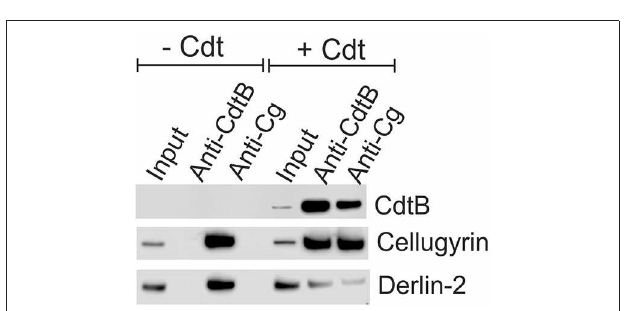
FIGURE 4 | Immunoprecipitation of cellugyrin, Derlin-2, and CdtB. THP-1 WT cells were treated with medium or Cdt (2 µ g/ml) for 2h and then washed and homogenized as described in Materials and Methods. Supernatants were immunoprecipitated with either immobilized anti-CdtB or anti-cellugyrin. The bound protein was eluted and analyzed by Western blot for the presence of CdtB, celluygrin, and Derlin-2. Results are representative of three experiments.